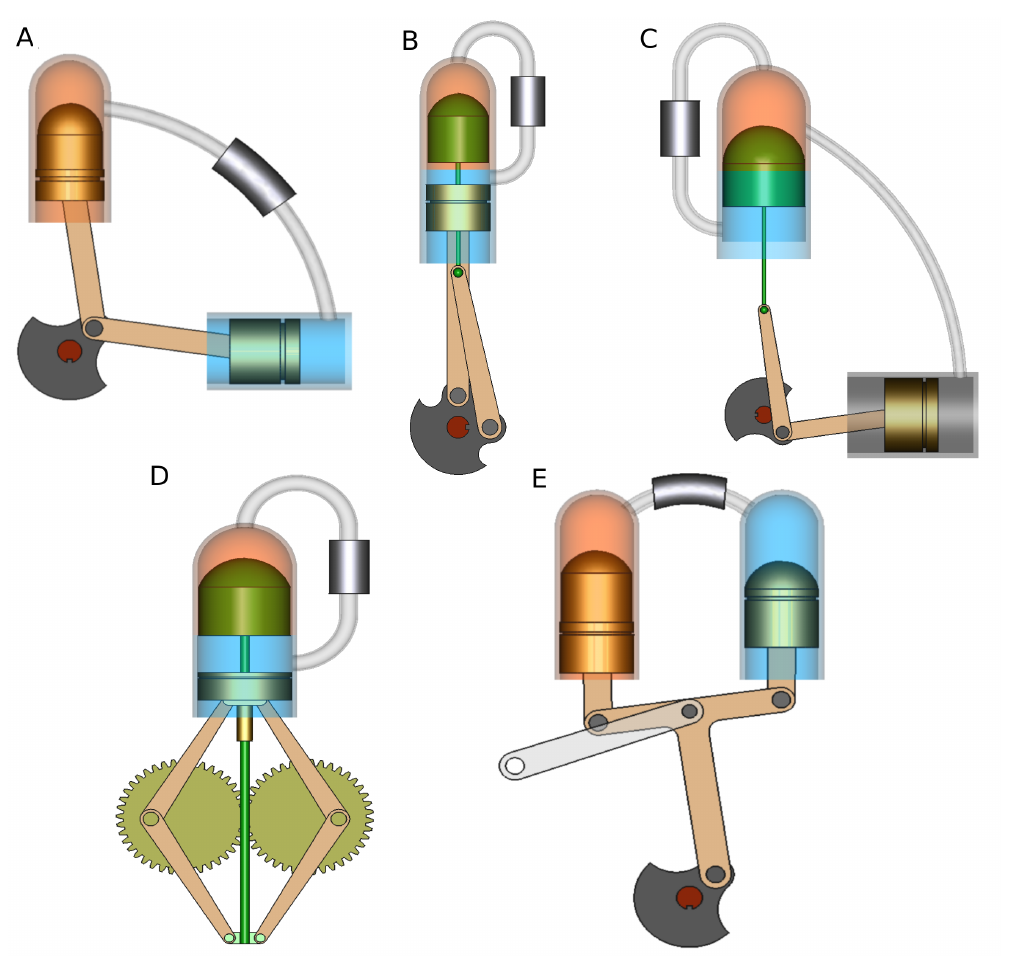
Figure 1. The five configurations considered in this